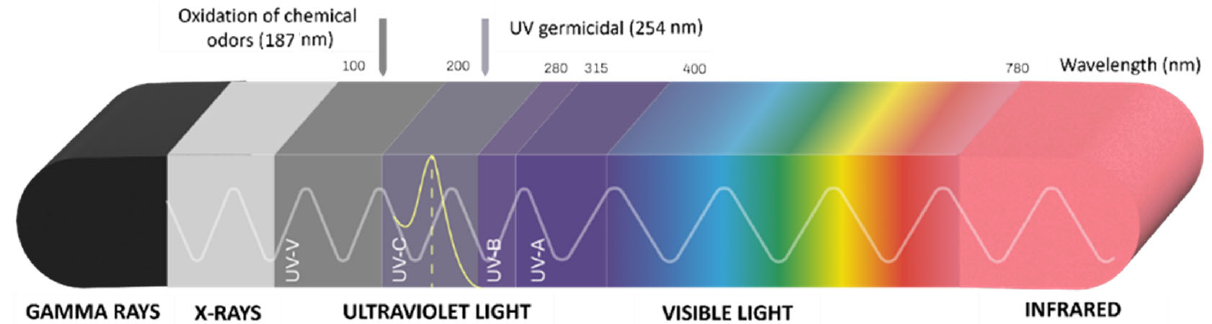
Figure 2. Electromagnetic spectrum including the types of UV radiation and the peak of UVGI higher effectiveness (254 nm). Adapted by Atmosfree with permission from Kowalski [84].